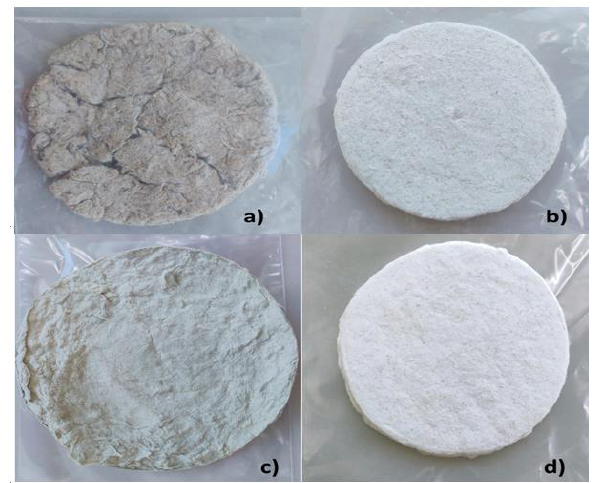
Fig. 3. Figures of ST pulp with soda-AQ cooking: before bleaching and washed with water (a); after bleaching and washed with water (b); before bleaching and washed with water and hexane (c); after bleaching and washed with water and hexane (d)